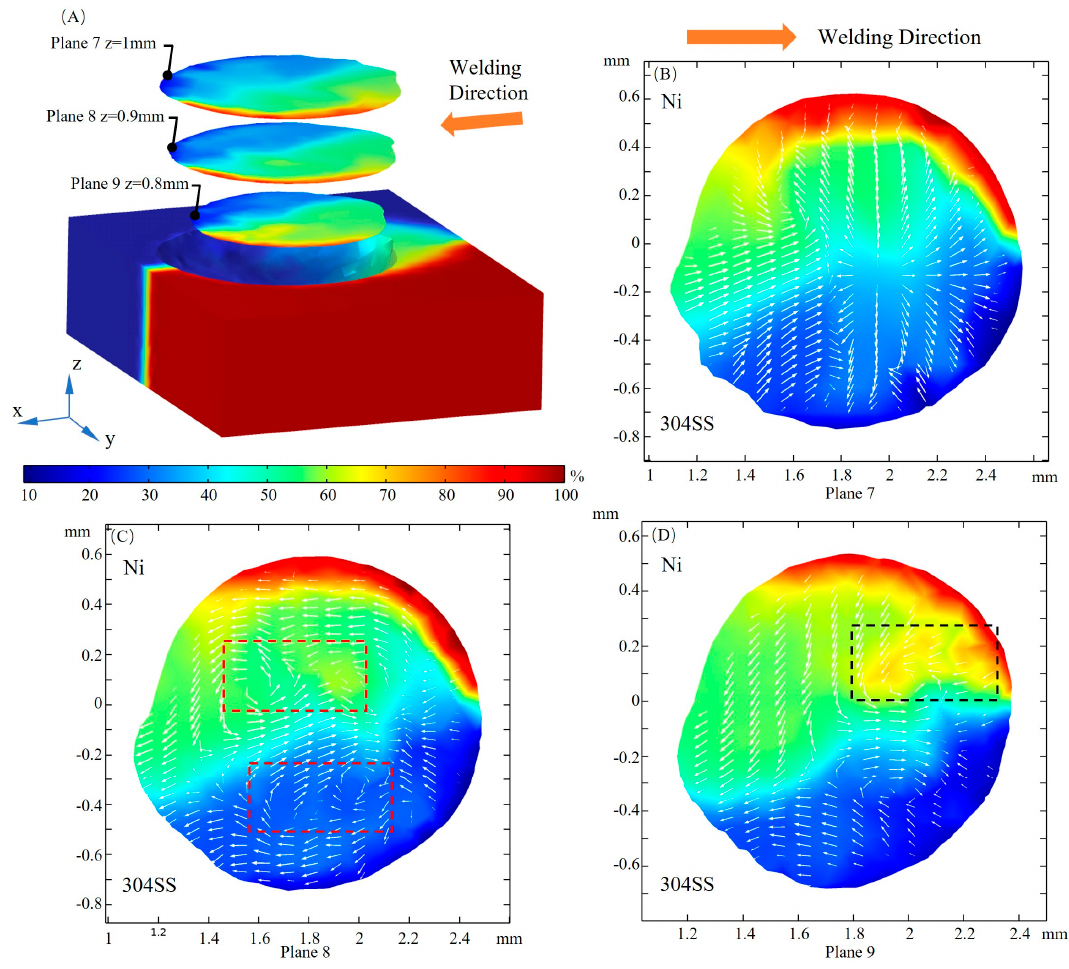
Figure 14. Ni concentration on xy sections. ( A ) 3D view; ( B ) z = 1 mm; ( C ) z = 0.9 mm; ( D ) z = 0.8 mm.